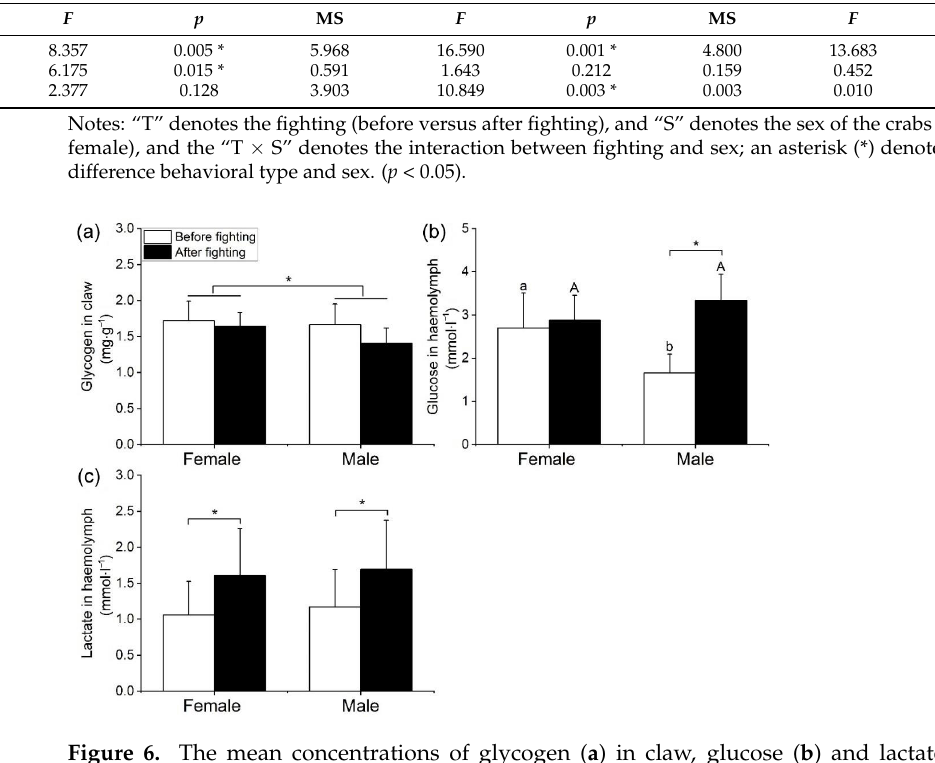
Figure 5. Concentrations of glycogen ( a ) in the claw, glucose in the hemolymph ( b ), and OCR of different individuals ( c ). Note: Capital letters represent significant difference of shy individuals between females and males; lowercase letters represent significant difference of bold individuals between females and males; an asterisk (*) denotes a significant difference of behaviors between two matched individuals. ( p < 0.05). Table 5. Results of two-way ANOVAs to determine the effects of sex and fighting on the concentrations of glycogen in claw, glucose, and lactate in the hemolymph of swimming crabs P. trituberculatus.